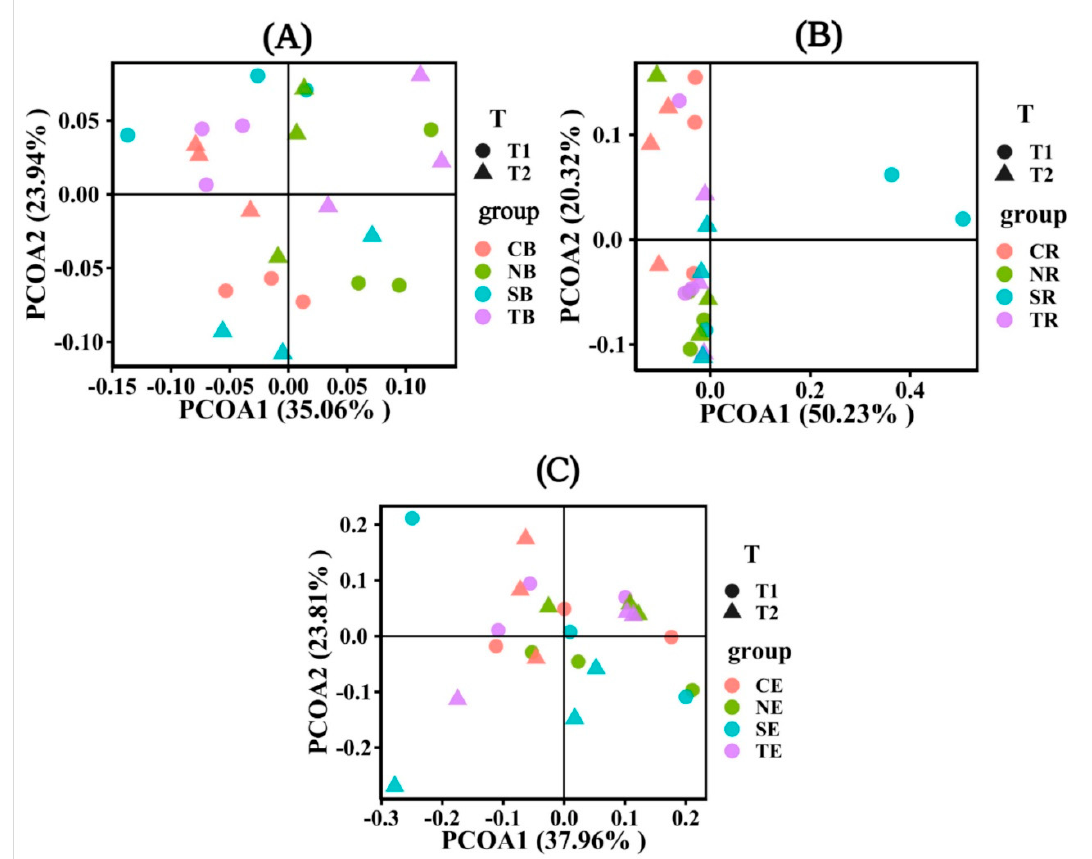
Figure 7. Principal coordinates analysis (PCoA) showed the abundance and diversity of bacterial microbial communities under different emergence phases (T1 for early phase and T2 for late phase) within the riparian zones of the Three Gorges Dam Reservoir, China. The factor loading of PCoA axes 1 and 2 explained 59%, 70.55%, and 61.77% of the total variation for bulk soil in ( A ), rhizosphere soil in ( B ), and endophyte in ( C ). Note: Abbreviations in the figure define as bulk soil (B), rhizosphere soil (R), endophyte (E), Cynodon dactylon (C), Hemarthria altissima (N), Salix matsudana (S), Taxodium distichum (T).